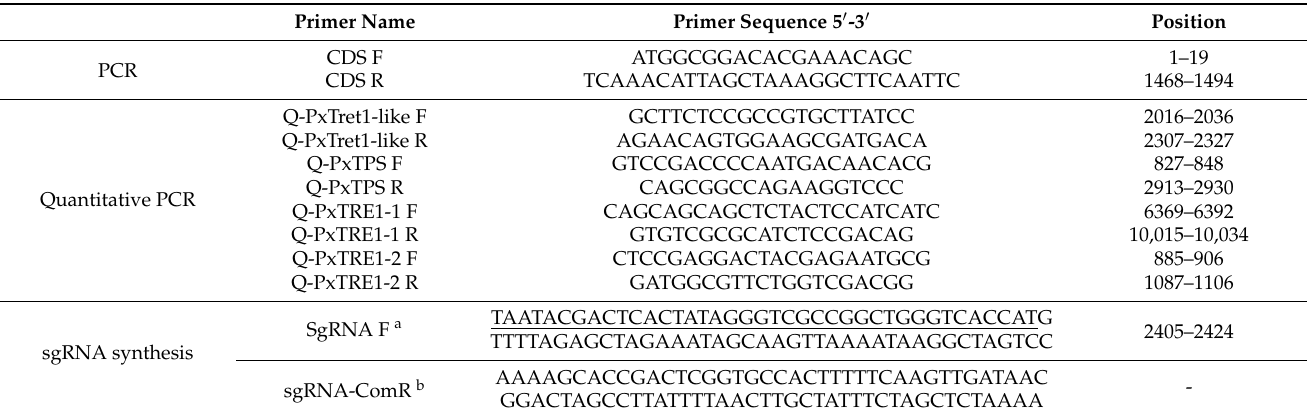
Table 3. Primers used in this